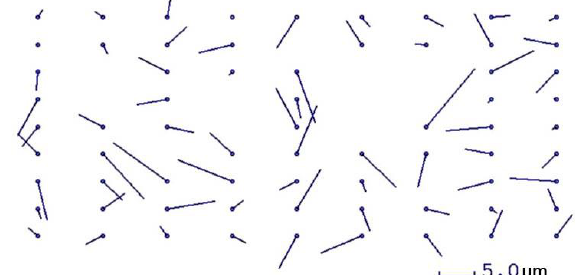
Figure 11: Superimposition of the image residuals of 37 orientations of data set 3, gridded in 9 x 9 cells